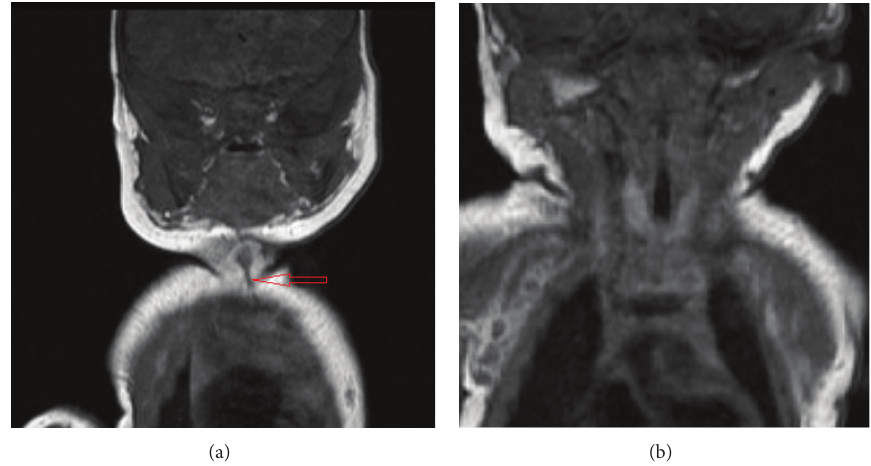
Figure 2: (a) Coronal T1 weighted MR image of neck demonstrates low T1 signal vertical midline cleft in cutaneous/subcutaneous region (open red arrow). (b) Coronal T1 image demonstrates normal right and left lobes of the